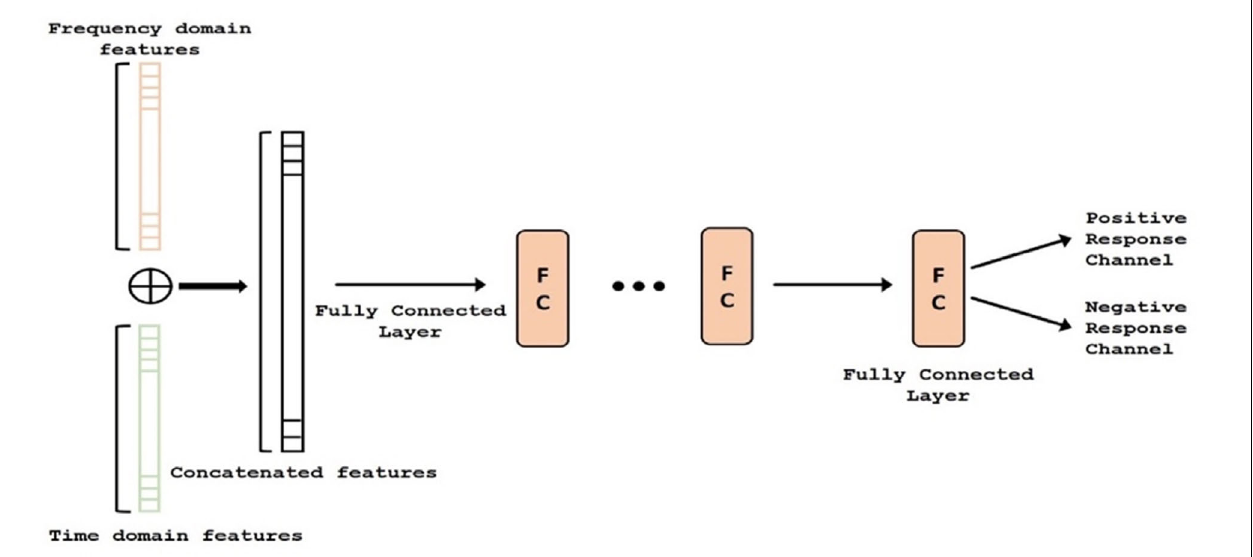
FIGURE 4 | Deep network structure of the fusion module. Auto regressive (AR) (i.e., frequency) features (orange) and time-domain features (green) are concatenated and classified. FC, Fully